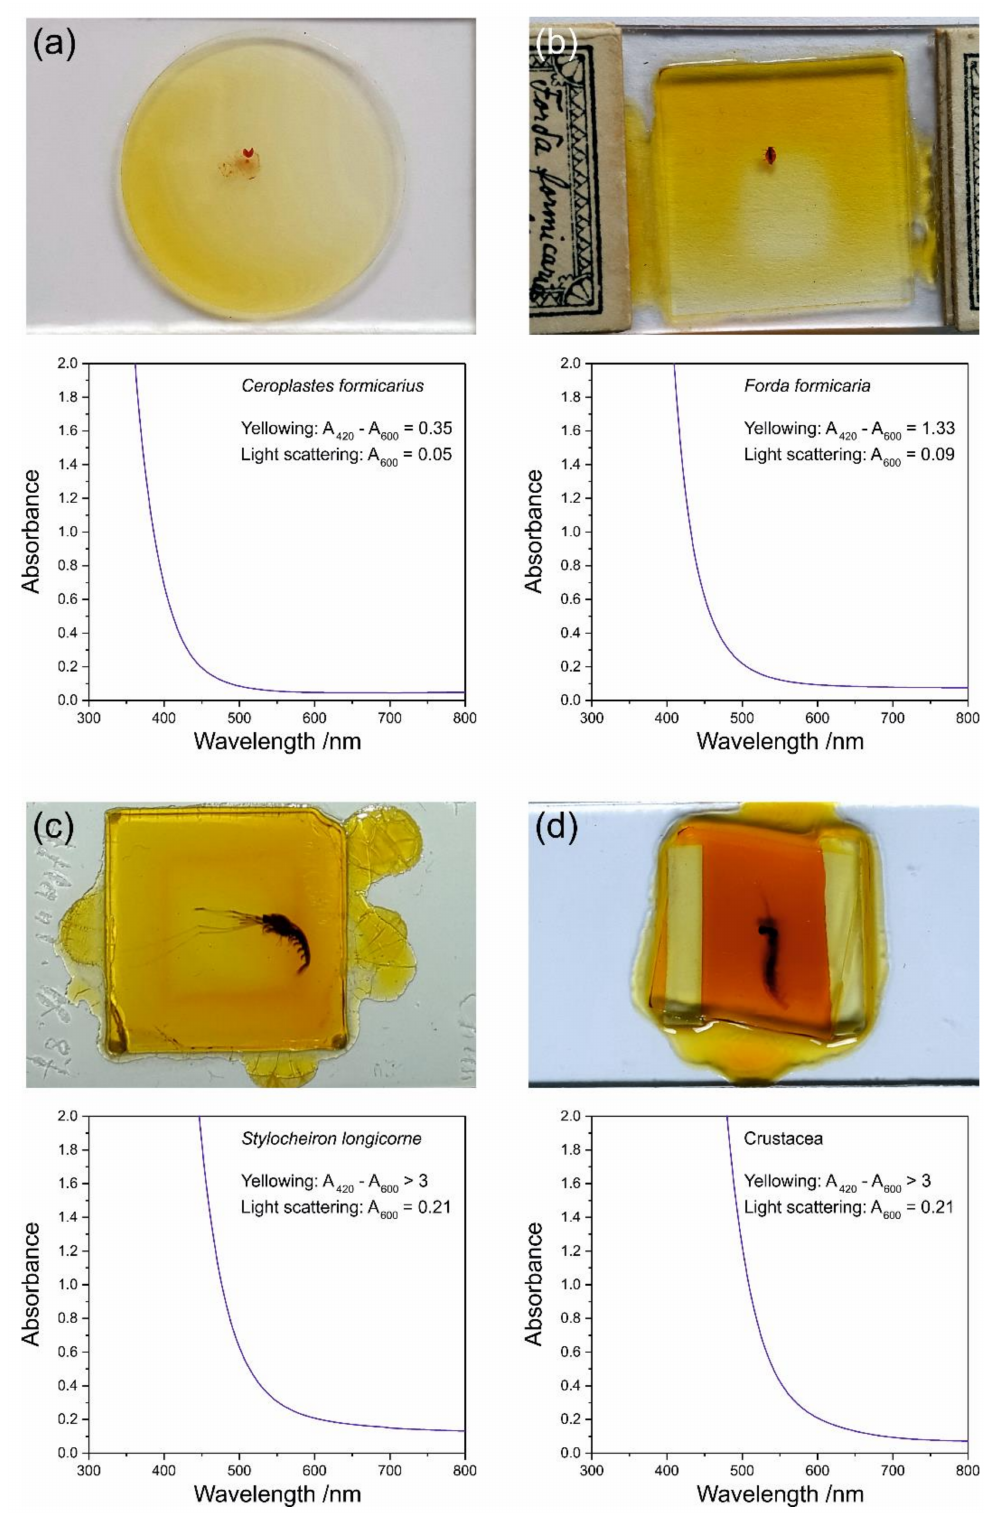
Figure 2. Yellowing as an ageing effect of Canada balsam observed in samples from natural history collections: ( a ) Ceroplastes formicarius , ( b ) Forda formicaria , ( c ) Stylocheiron longicorne , and ( d )